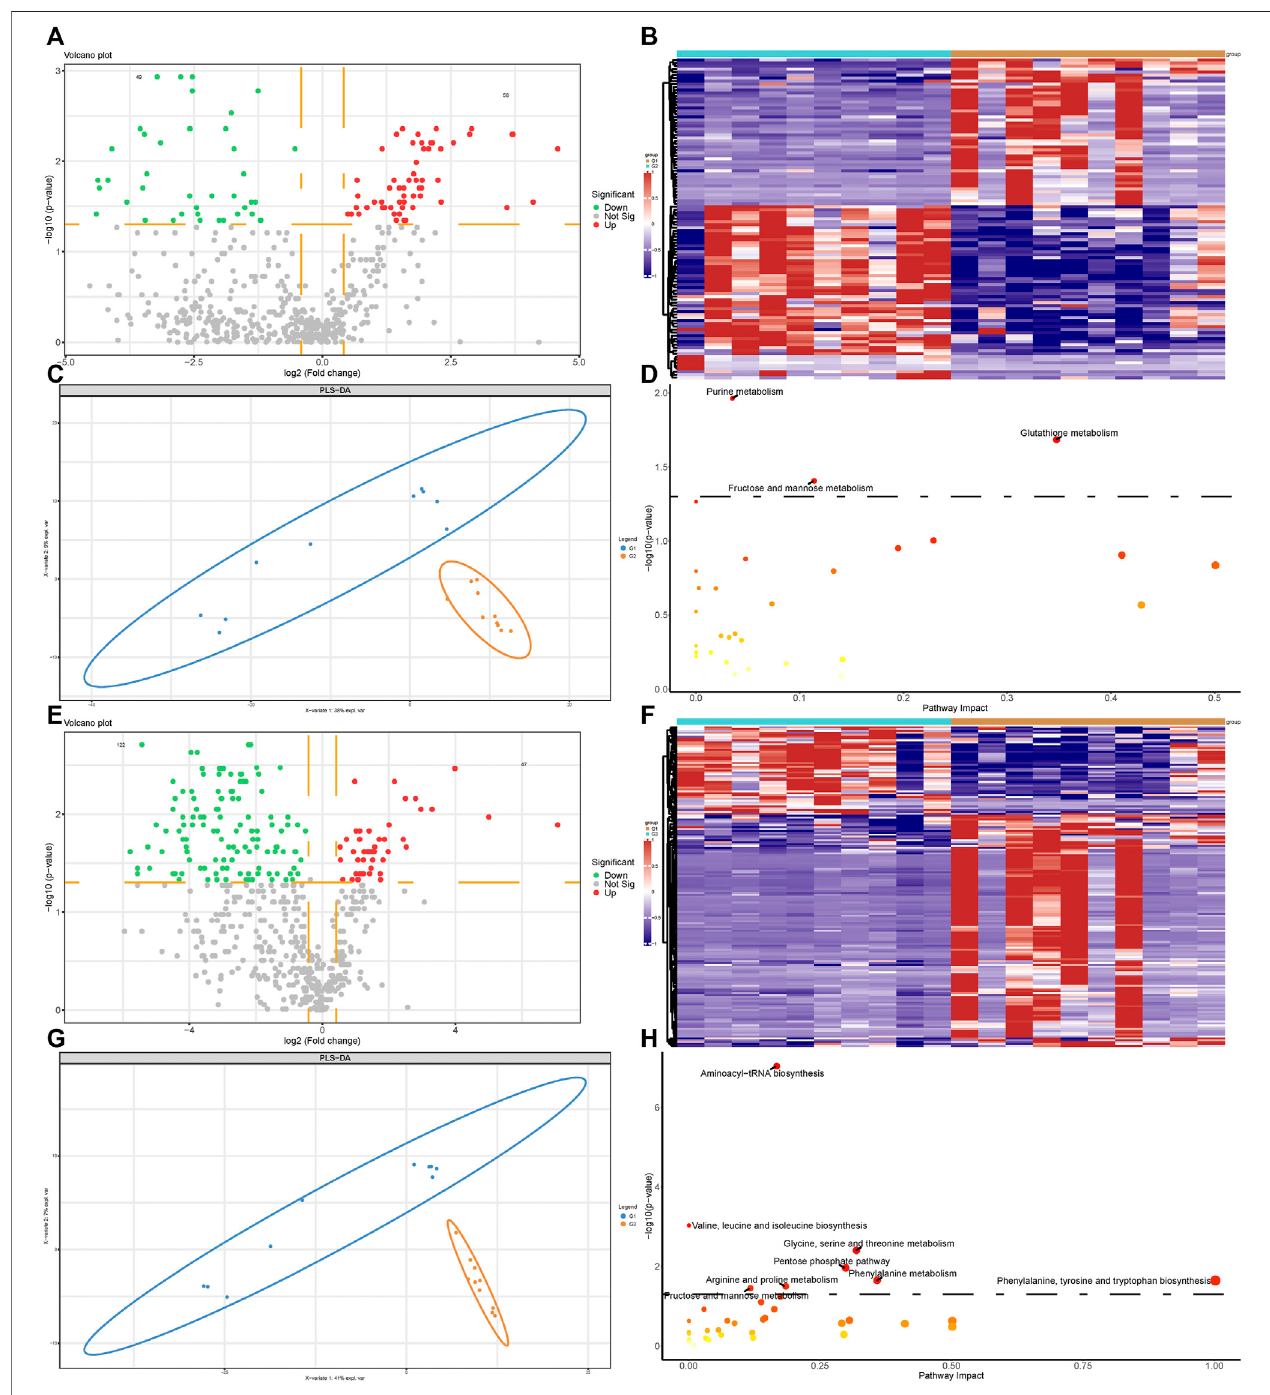
FIGURE 3 | Metabolomic pro fi ling analysis of valvular AF and non-valvular AF samples. (A,B) The volcano plot (A) and heatmap (B) showed the differently expressed metabolites in valvular AF comparedto SRsamples. (C) PLSDA analysisshowed the protein pro fi les between valvular AF and SRtissues. (D) KEGG analysis ofdifferentlyexpressedmetabolitesinvalvularAF. (E,F) Thevolcanoplot (E) andheatmap (F) showedthedifferentlyexpressedmetabolitesinnon-valvularAFcompared to SR samples. (G) PLSDA analysis showed the protein pro fi les betweennon-valvular AF and SRtissues (H) KEGG analysis ofdifferently expressed metabolites in non-valvular